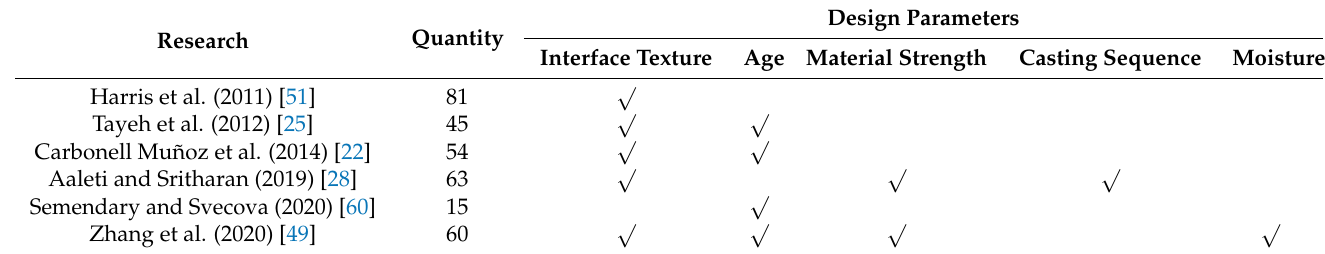
Table 4. Parameters considered in the collected slant shear tests.